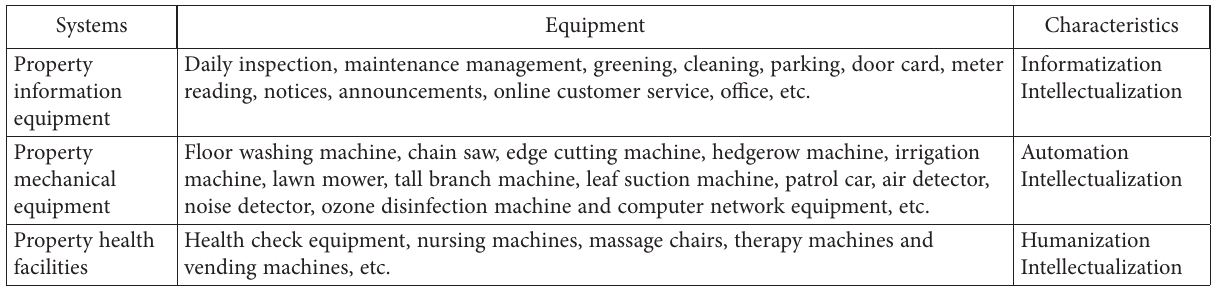
Table 4. Intelligent management system, equipment and